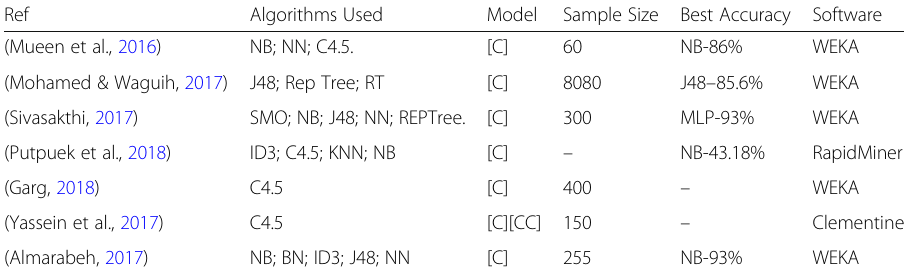
Table 4 Summary of results of research seeking course level prediction